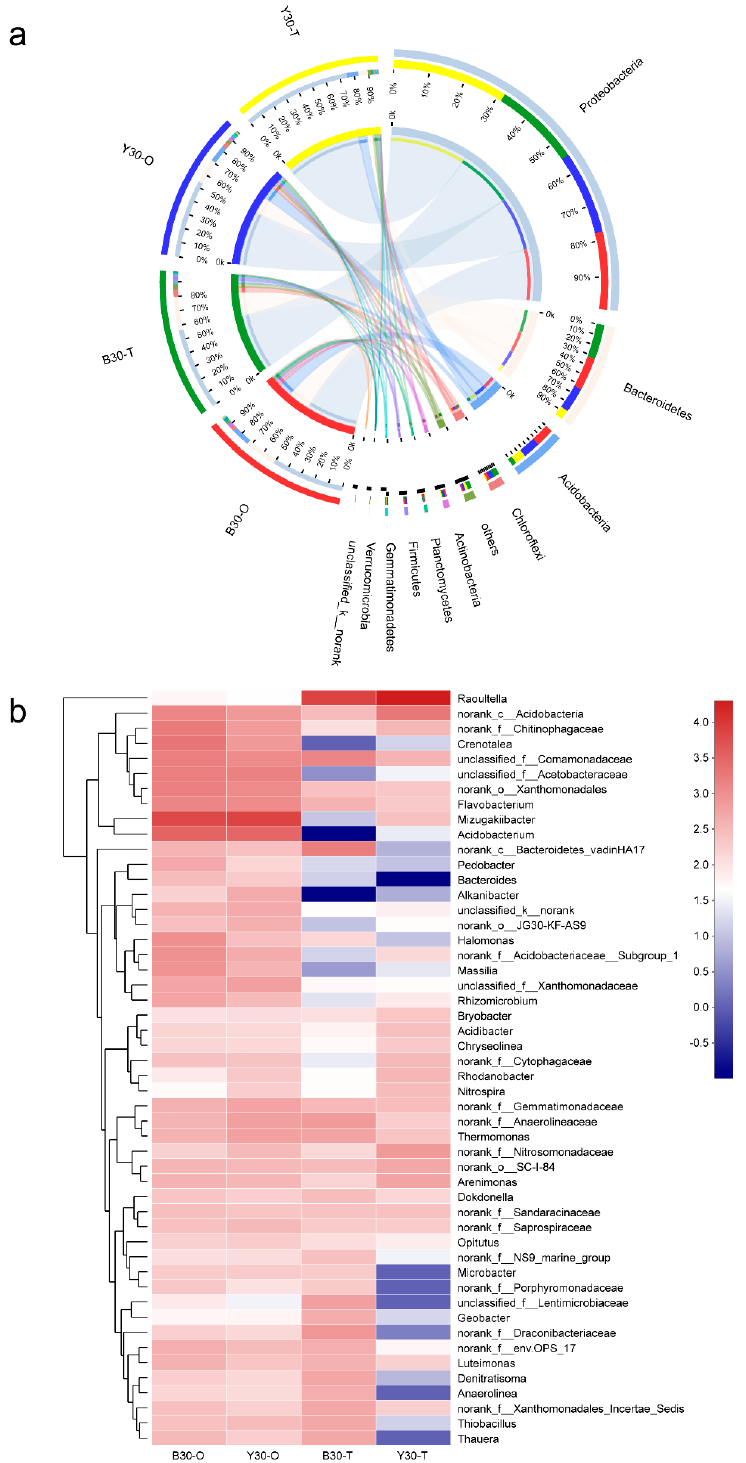
Figure 3. ( a ) Circos diagram showing the relative abundance of the bacterial communities at the phylum level, ( b ) Heatmap showing the relative abundance of bacterial communities at the genus level. B30-O and Y30-O stand for original soil samples, while B30-T and Y30-T stand for soil samples collected on day 65.